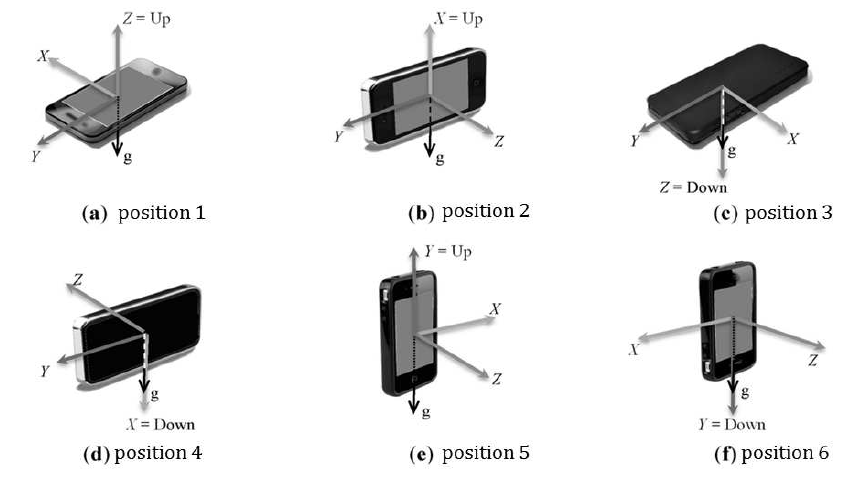
Figure 6. Smartphone axes in different directions. This figure has been reproduced from